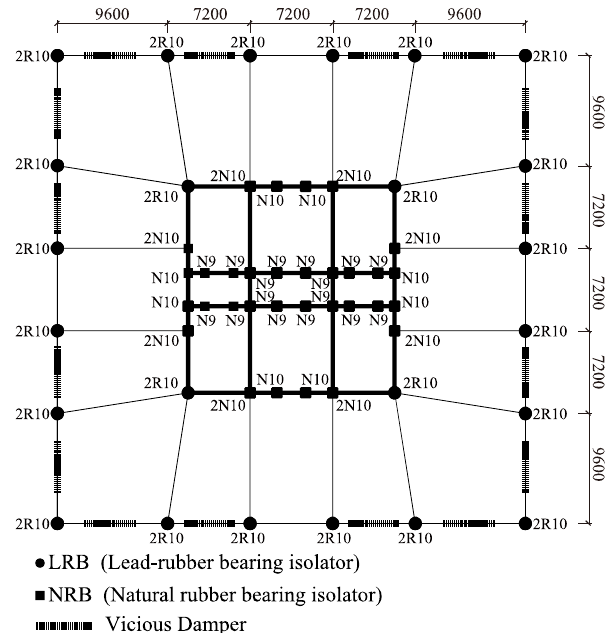
Figure 16. Isolation system with nonlinear fluid viscous dampers (NFVDs) of the RC frame ‐ core tube building. Table 6. Critical design parameters and indexes of the isolated tall building with